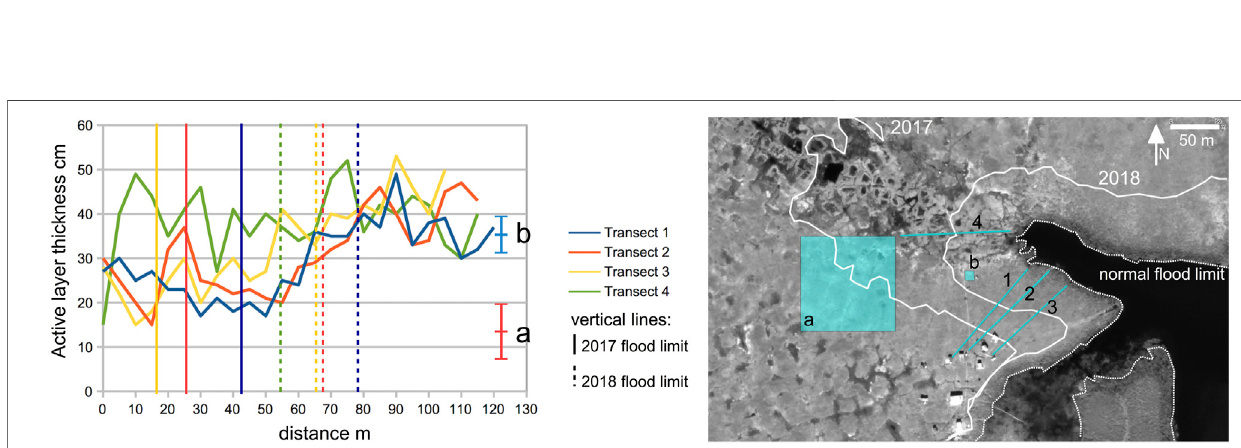
Frontiers in Earth Science |